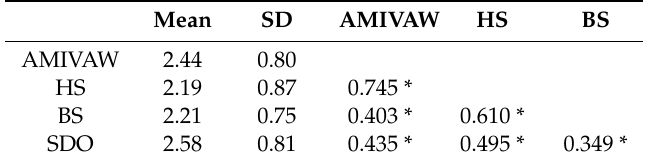
Table 1. Descriptive statistics and Pearson correlation values between variables.